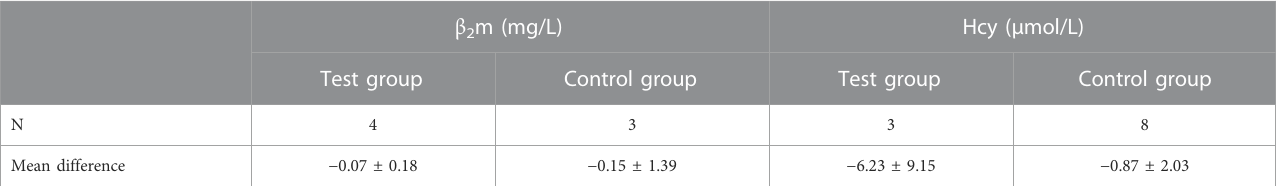
TABLE 6 Changes in β 2 m and